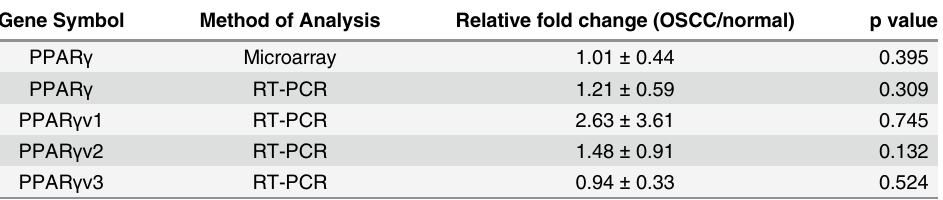
Table 6. Comparative Expression of PPAR γ and PPAR γ Transcript Variants in OSCC and Normal Oral Tissues from NQO-Treated